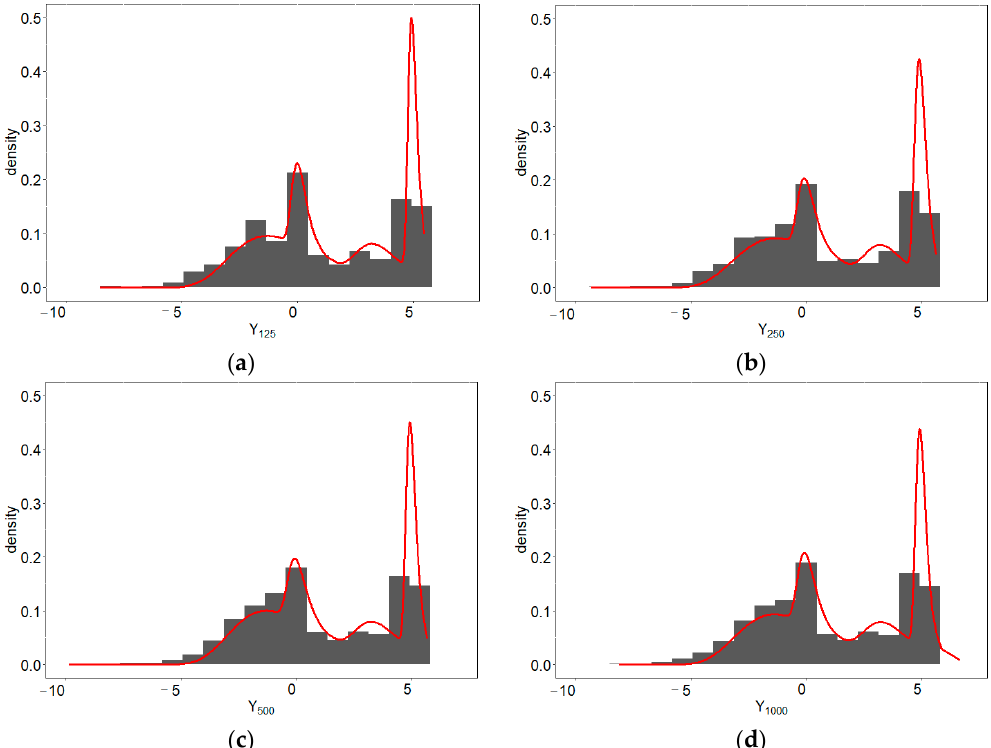
Figure 4. Histograms and predictive densities for the four-component EV-I mixture distribution with ( a ) 125, ( b ) 250, ( c ) 500, and ( d ) 1000 samples per component.